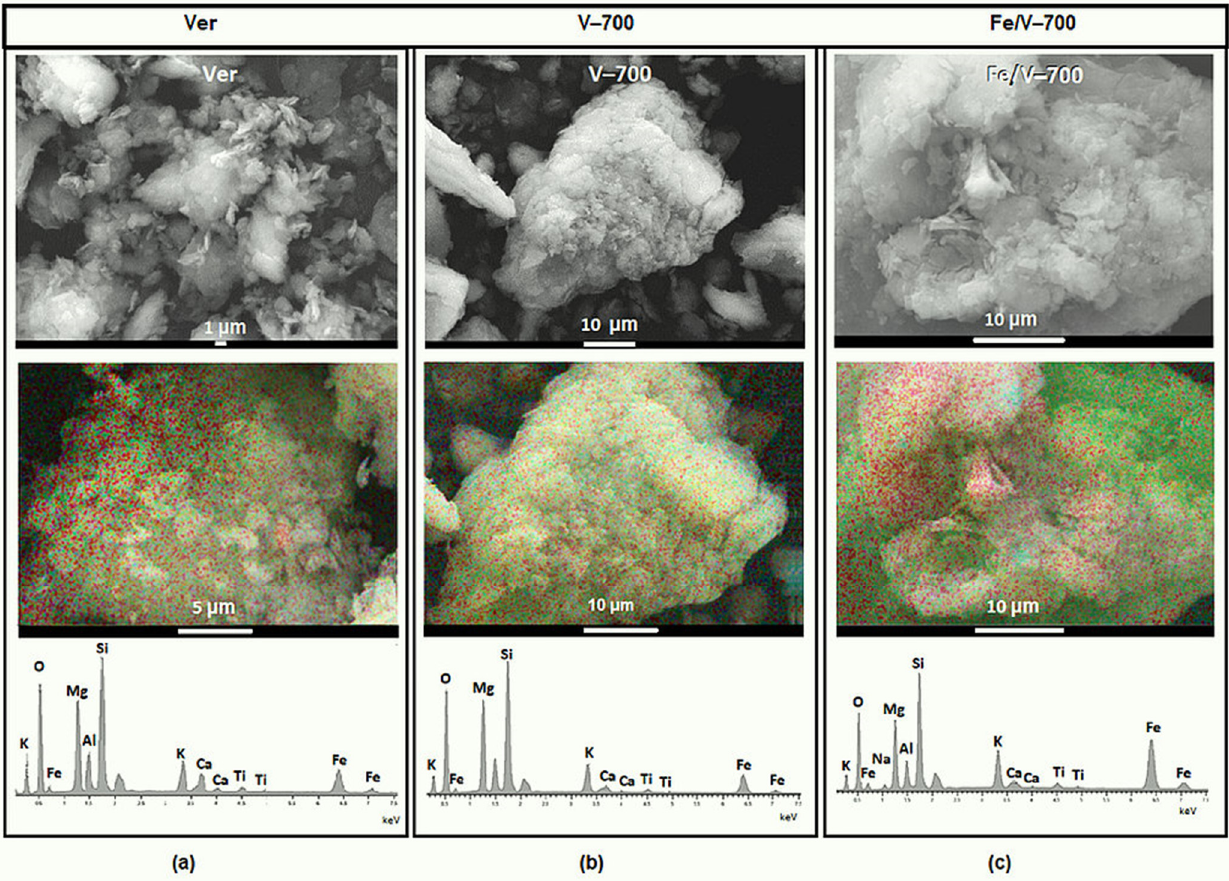
Figure 1. SEM images and EDX scanning distribution of Fe (red points) on the surface with the EDX elemental spectra of: ( a ) Ver, ( b ) V–700 and ( c ) Fe/V–700. elemental spectra of: ( a ) Ver, ( b ) V–700 and ( c ) Fe/V–700. Hydroxyapatite (marked as HA, JCPDS card no. 00-064-0738) was a mineral